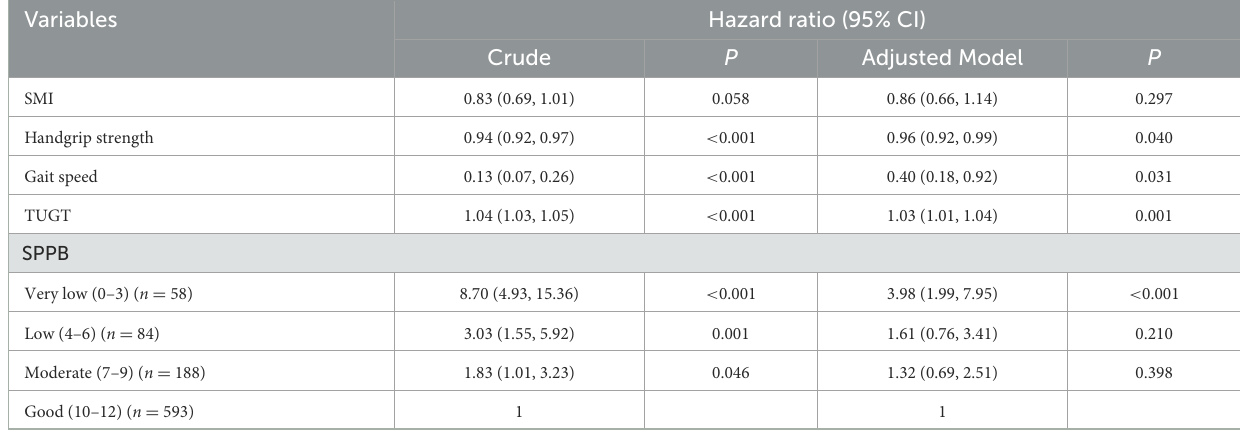
TABLE 2 Cox regression model for the physical performance indexes as a predictor for the risk of mortality.